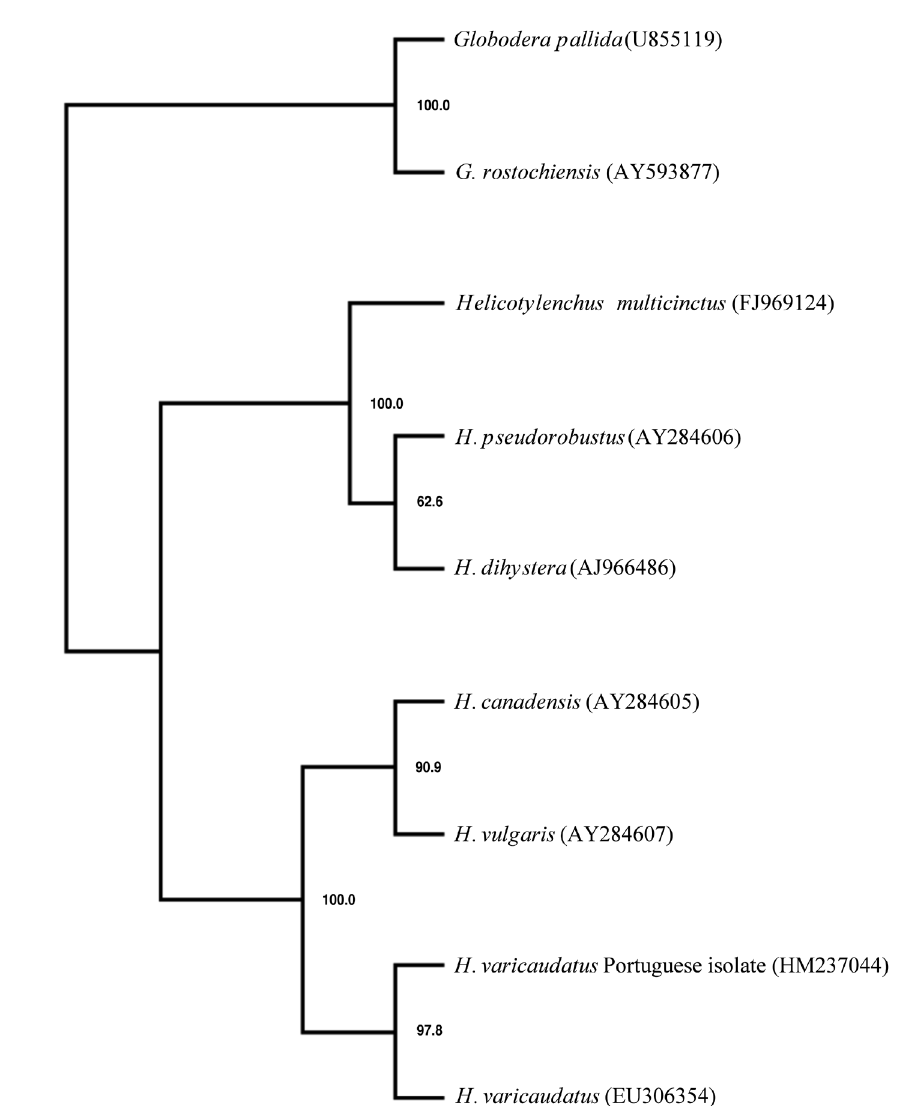
Figure 5. Maximum likelihood (ML) tree of Helicotylenchus species retrieved from the GenBank database and from the Portuguese isolate aligned with Clustal W (Thompson et al ., 1994) with Globodera pallida and G. rostochiensis as outgroup. ML was performed using PAUP* 4.0b10 (Swofford, 2002). Robustness of the inferred tree was tested using nonparametric bootstrapping (with 1000 pseudoreplicates). GenBank accession codes are shown in parentheses. Bootstrap support values are indicated at